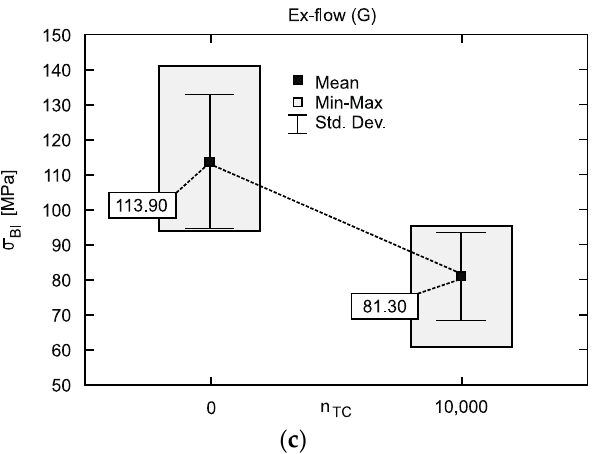
Figure 4. Tensile strength in the BFS test ( a ) Filtek Z550 composite, ( b ) Ex-nano (G) composite, ( c ) Ex-flow (G) composite.